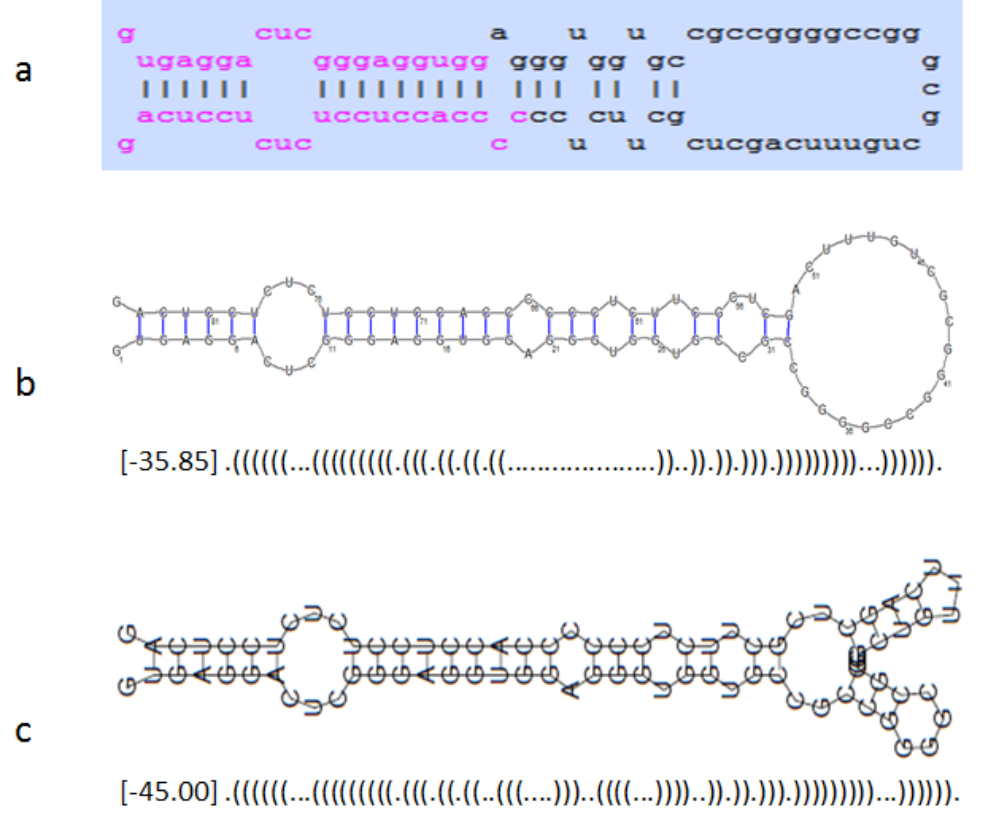
Figure 2: miRBase entry hsa-mir-1224 (MI0003764) showing stem-loop structure (a). Pink bases indicate mature miRNA sequences. Manually created dot-bracket structure and structure graph by RNAShapes (b). RNAFold prediction (c). Minimum free energy is given within